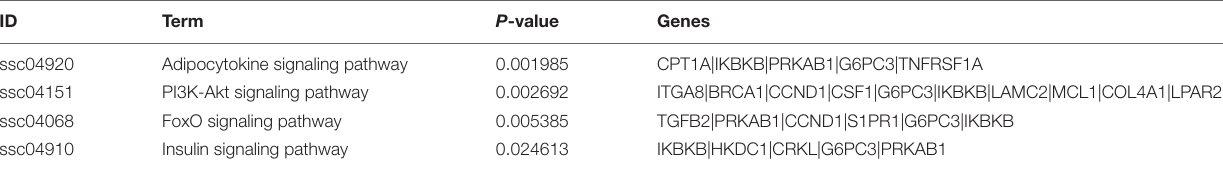
TABLE 2 | Summary of KEGG pathways associated with